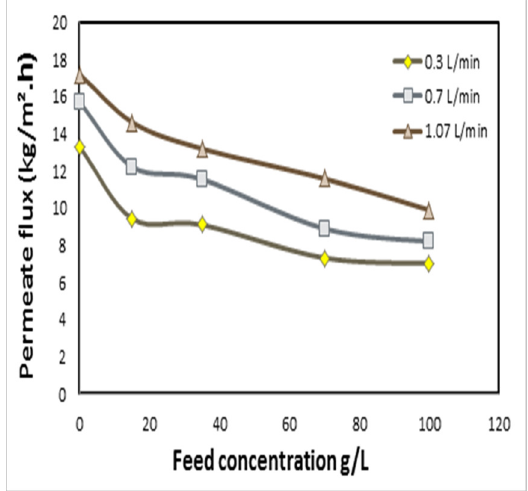
Fig. 6. Influence of feeding flow rate on the permeation flux at different feed temperatures and 35 g/L NaCl feed solution.